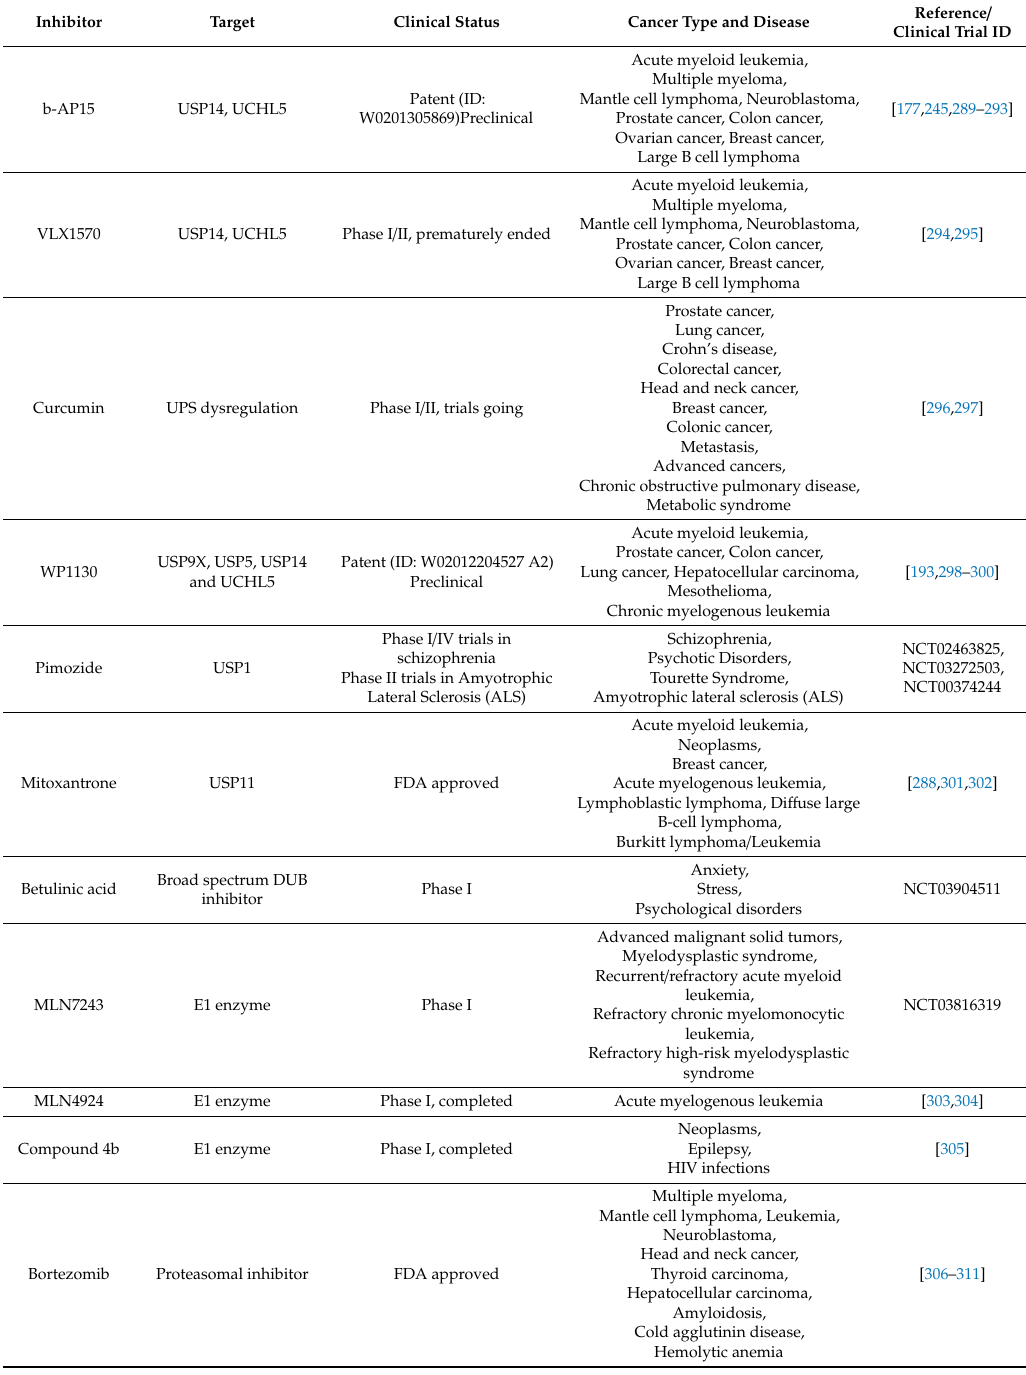
Table 3. Clinical status and disease association of UPS system